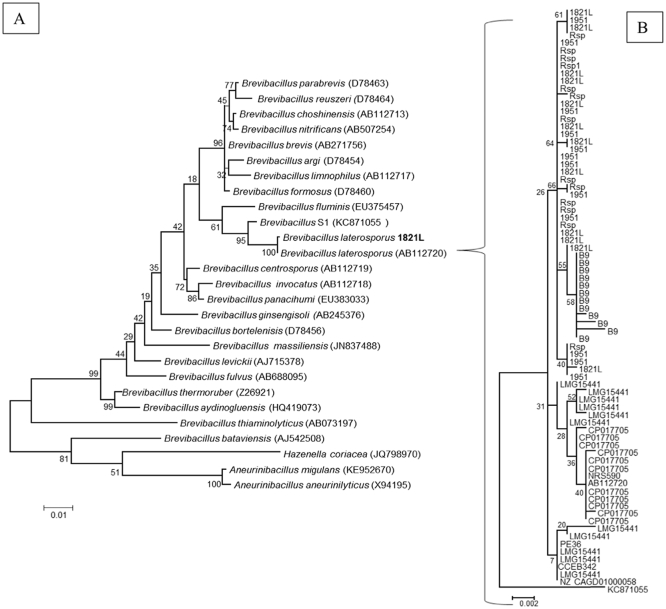
Trees generated from alignment of 16S rDNA sequences of Brevibacillus laterosporus genomes. A) Placement of 1821L (New Zealand) in the tree from Zheng et al. [98]. B) Alignment of all 16S rDNA gene sequences. Bar = A) 0.01 nt substitutions per site and B) 0.002 nt substitutions per site.